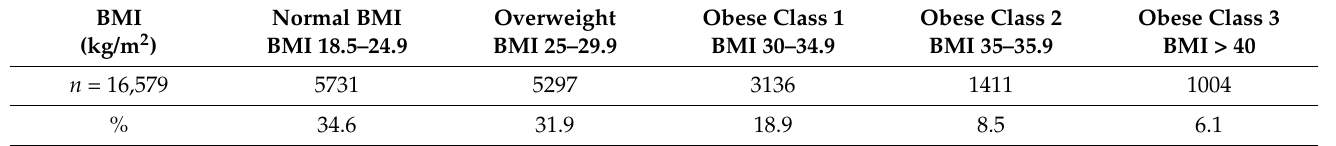
Table 1. BMI categories of patients between 18–79 years excluding underweight patients. BMI Normal (kg/m 2 )